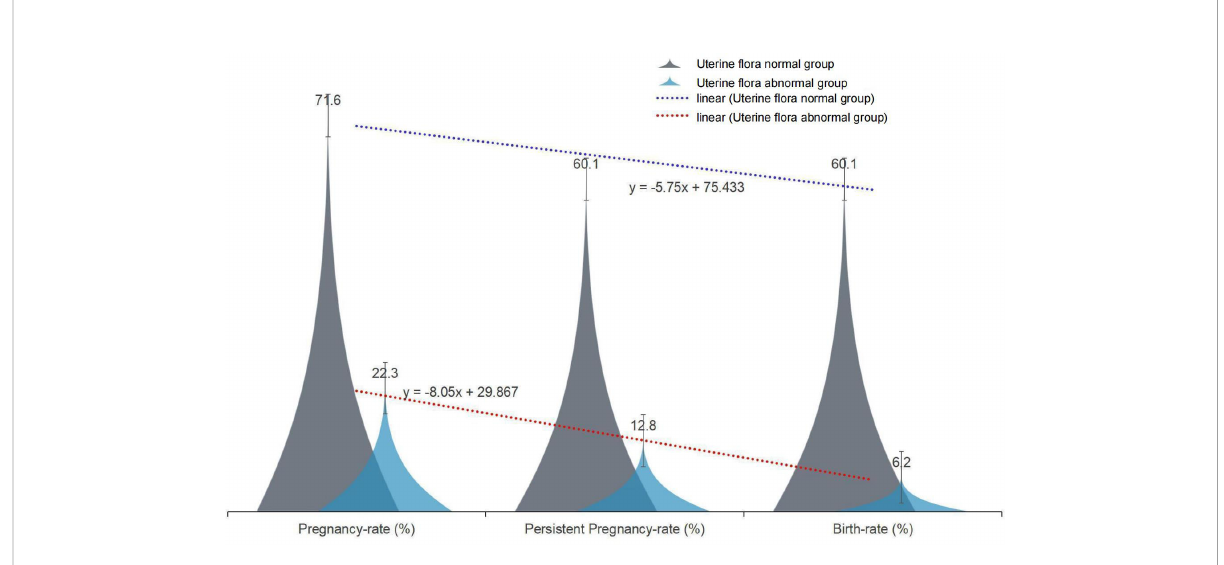
FIGURE 1 The effect of normal and abnormal uterine microbiota on pregnancy